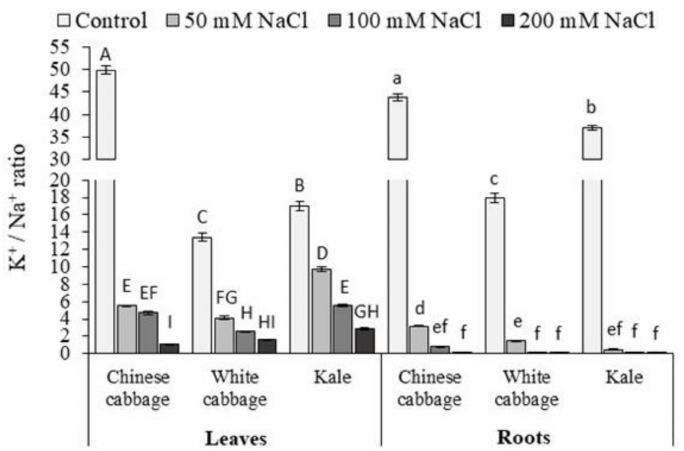
Figure 1. K + /Na + ratio in Brassica leafy vegetables (Chinese cabbage, white cabbage, and kale) leaves and roots upon salinity treatments. Data labeled with different letters differed significantly at p < 0.05. Statistical analysis was performed among three Brassica leafy vegetables, separately for leaves (capital letters) and roots (small letters).